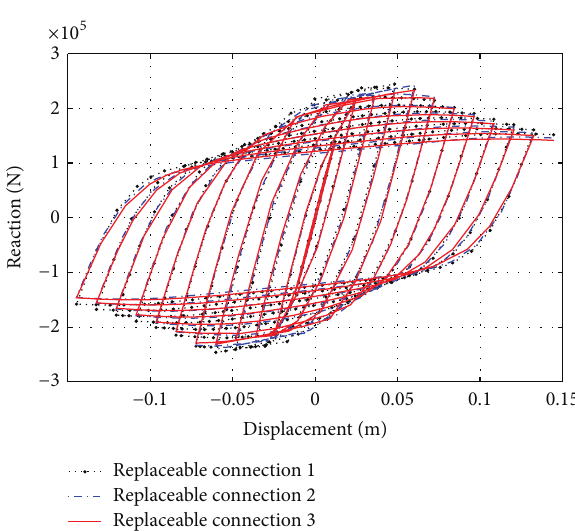
Figure 17: Hysteresis curve of different connections.